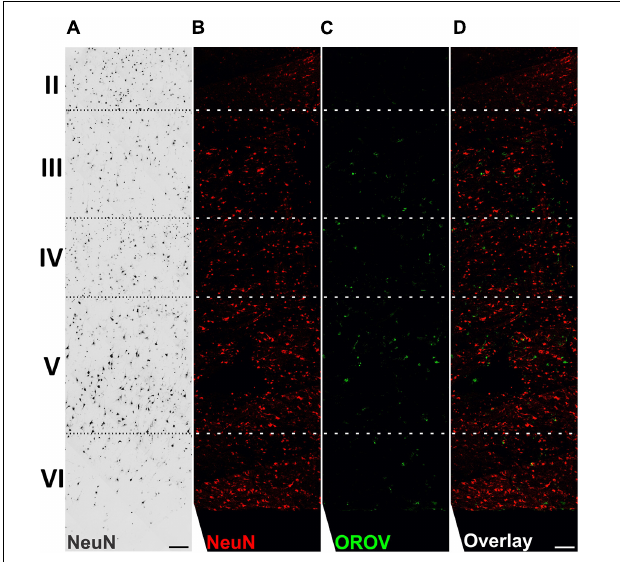
in vitro 4) from middle temporal gyrus were labeled with the neuronal marker NeuN, and with anti-OROV antibody (C,D) . Representative multiphoton images from an OROV-infected slice (B–D) are shown. A brightfield image from a control (non-infected) slice is also shown for reference (A) . Cortical brain layers (II–VI), assigned according to neuronal morphology and density, are indicated on the left. Scale bar = 100 µ m.